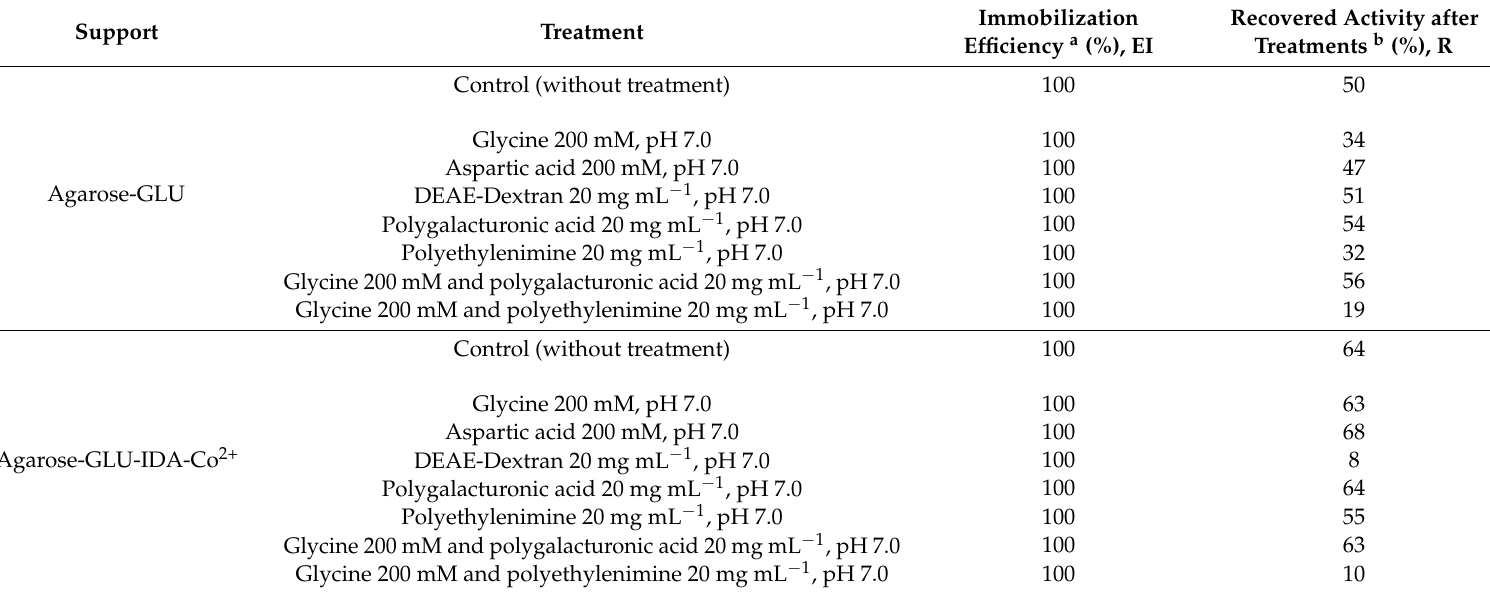
Table 1. Immobilization of Ea BglA on activated agarose supports followed by post-immobilization with poly-functional